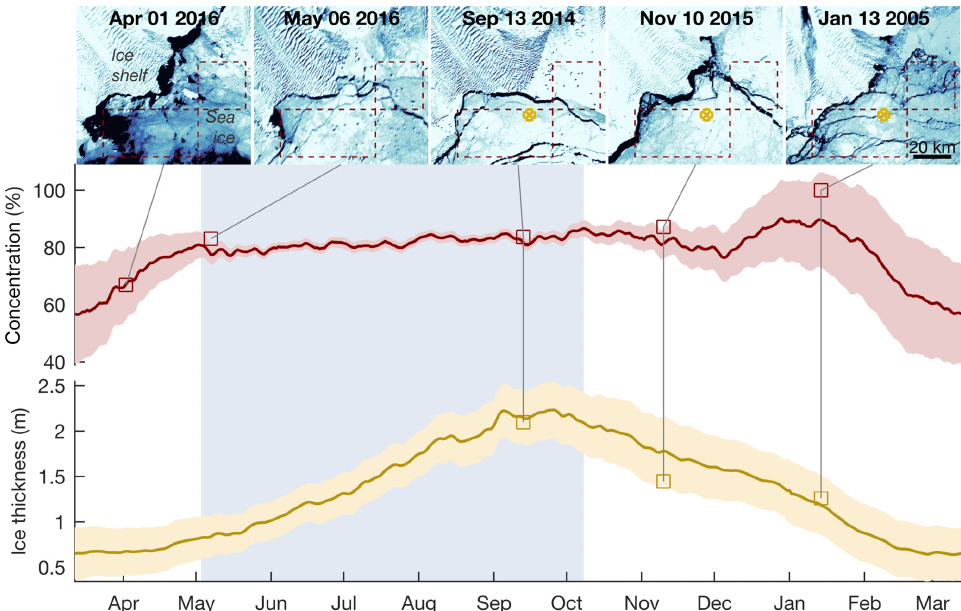
Figure 6. Seasonal cycle of sea ice at the TIS front. MODIS visual band imagery (Scambos et al., 2001), remotely sensed ice concentration (Cavalieri et al., 1996), and ECCO v4-r3 effective sea ice thickness (Fukumori et al., 2017) reveal a seasonal cycle of sea ice growth and decay beginning around 12 March each year, when sea ice concentration is at a minimum. Ice concentration and thickness time series are shown with shading indicating daily values of ± 1 σ . Light blue background shading indicates the presence of fast ice at the TIS front, from about 3 May to 8 October. During this winter period, remotely sensed ice concentration values remain relatively constant despite continued growth of sea ice. Average sea ice thickness steadily declines throughout the summer, while thin, unconsolidated sea ice often temporarily fills the area and is detected by remote sensors. Five example MODIS images (Scambos et al., 2001) show sea ice fastened to half of the TIS front in May and September, with dashed quadrangles indicating the region of ice concentration averaging and a gold marker denotes the location of the ECCO sea ice thickness time series (not shown for 2016, when no ECCO v4-r3 data are